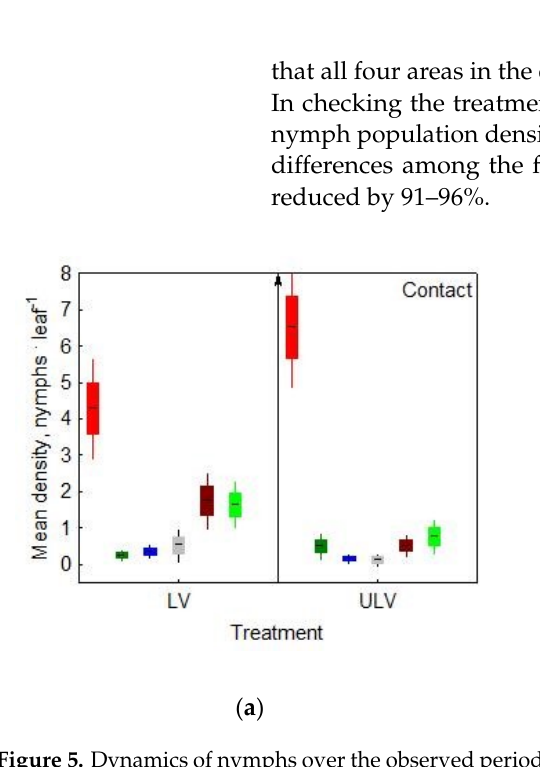
Figure 5. Dynamics of nymphs over the observed period (Moment 0, before spraying, and M1–M5, five moments after spraying) separated by treatment volume (LV or ULV) and insecticide type: ( a ) contact insecticide; and ( b ) systemic insecticide.